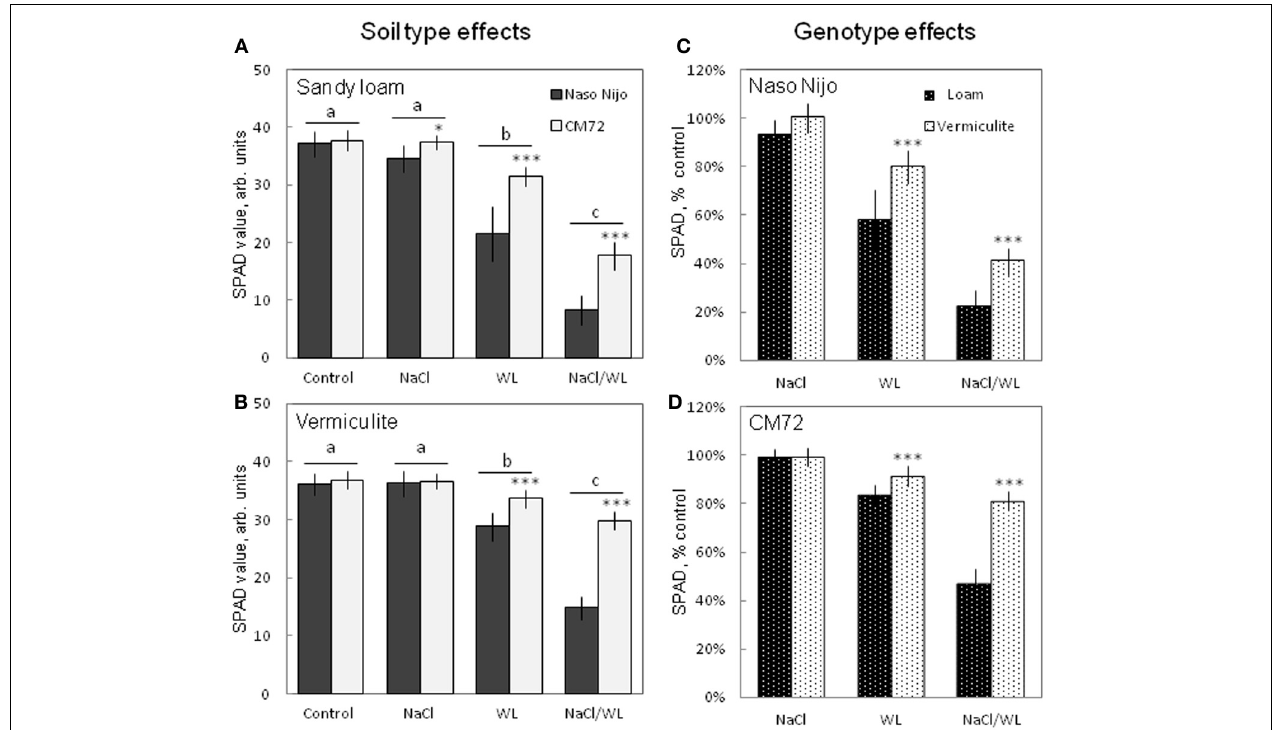
treatments, and media composition, refer to the Materials and Methods section. Mean ± SD ( n = 12). Different lower case letters indicate the significant difference between treatments (averaged for both genotypes) at P < 0 . 01. Asterisks indicate the significant difference between cultivars within the treatment at ∗ P < 0 . 01 and ∗∗∗ P < 0 .